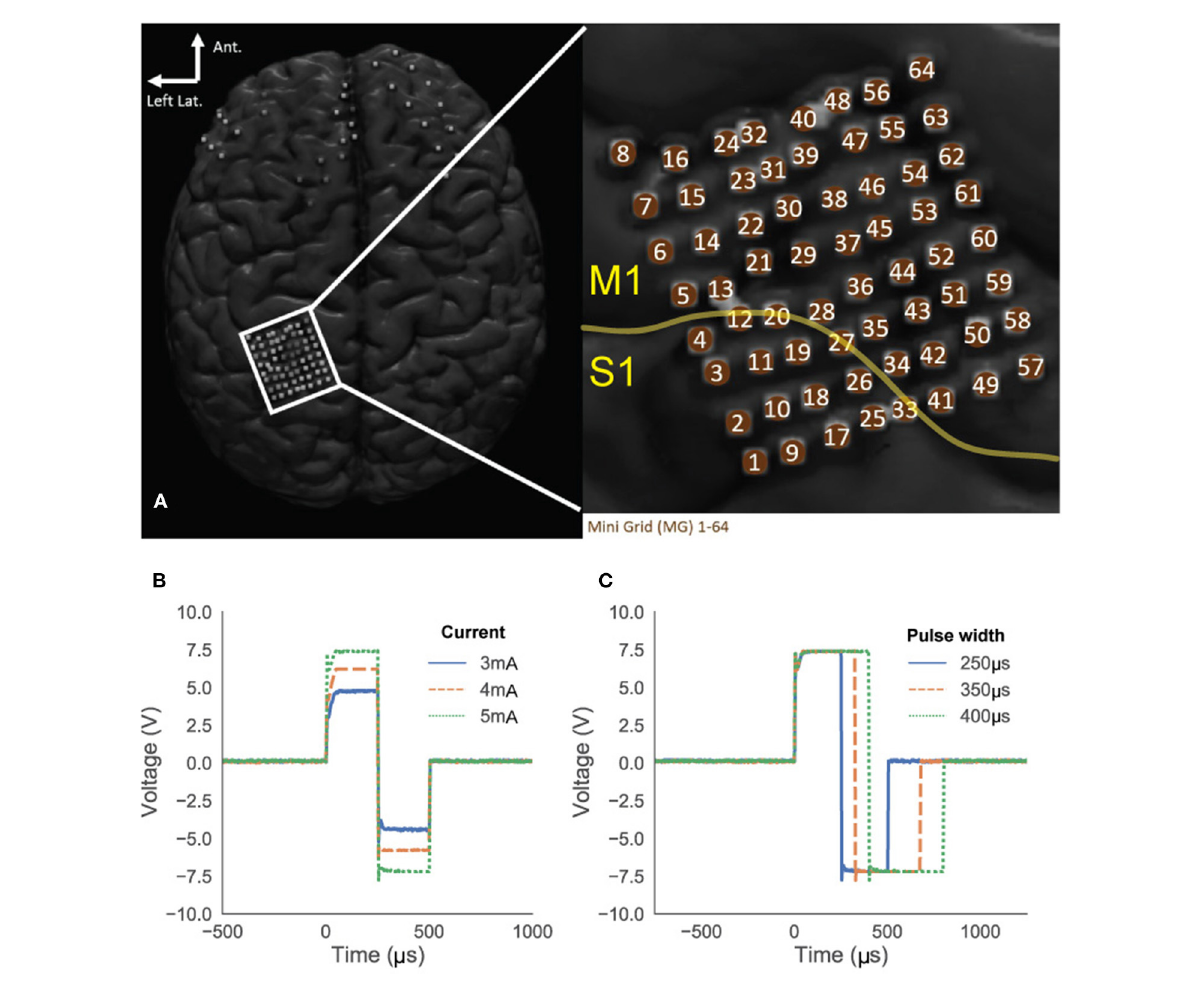
FIGURE12 Subject’s ECoG grid placements (A) . The yellow line indicates the estimated central sulcus which divide primary motor cortex (M1) and sensory cortex (S1) suggesting that the most of the grid space may elicit motor response. (B, C) Stimulation pulses in the patient’s brain recorded from electrode 49 and 50. Amplitude sweeping from 3 to 5 mA (B) and pulse width sweeping from 250 to 400 µ s (C)